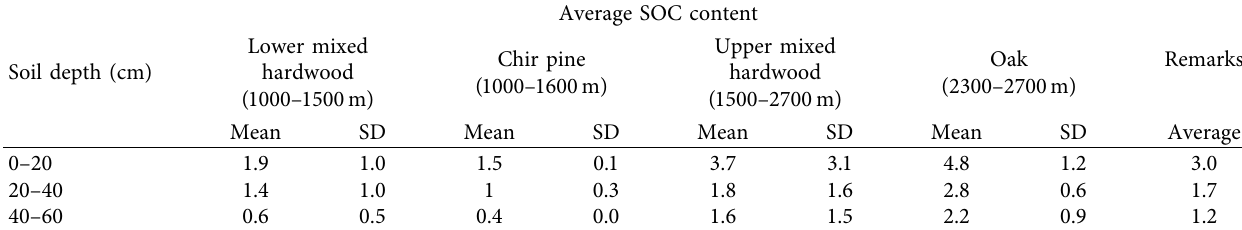
Table 2: SOC concentration at different soil depths of different forest